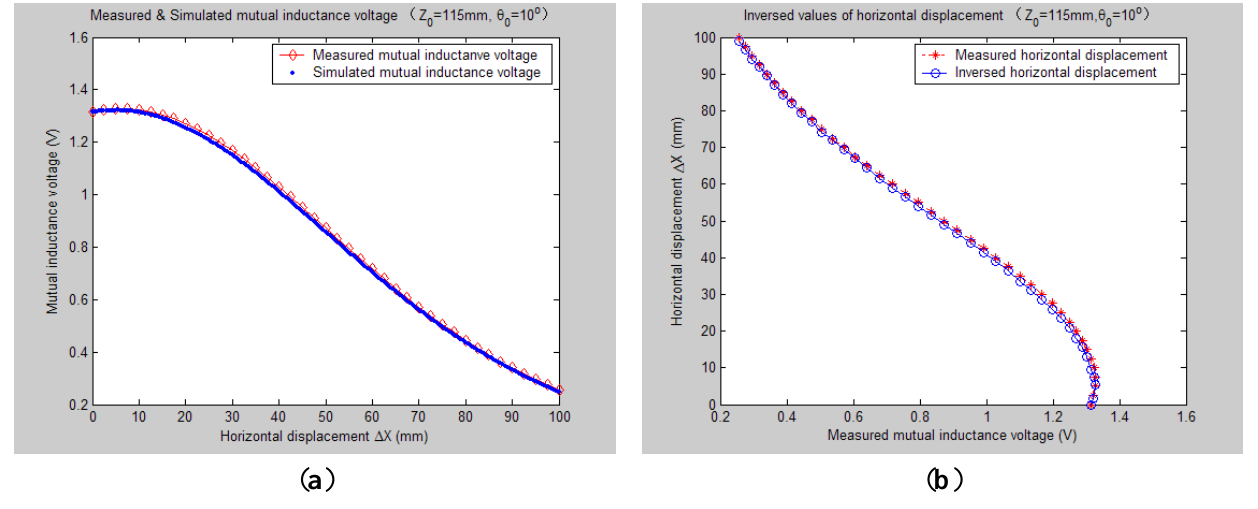
= 10°, Z = 115 mm). 0 0